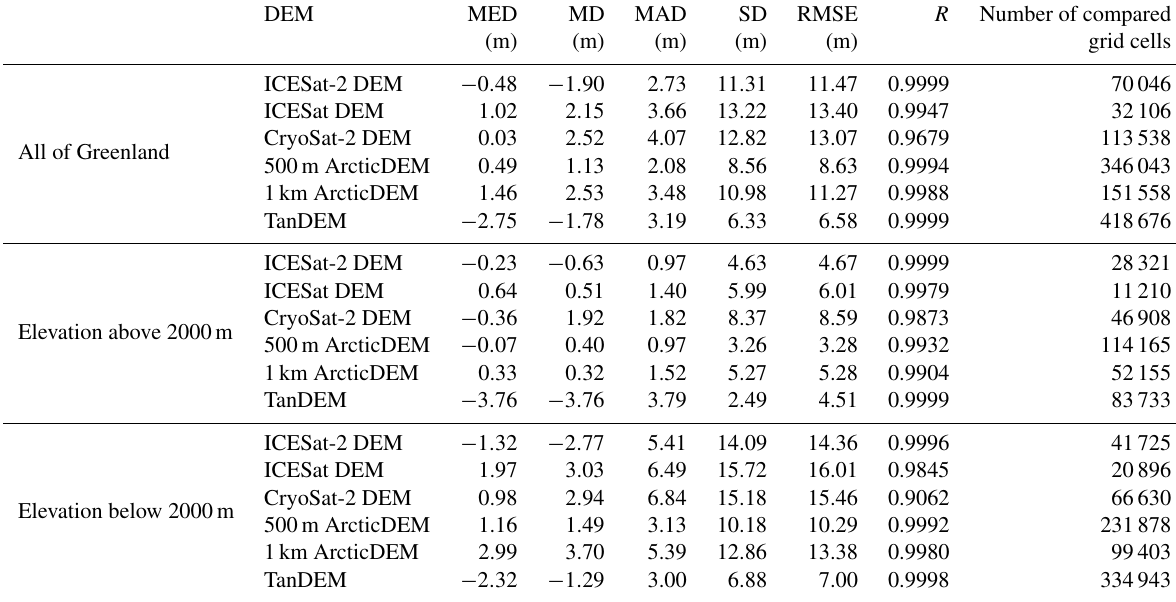
Table 5. Elevation differences of the ICESat-2 DEM and other published DEMs with respect to IceBridge data. All of Greenland and the regions with elevations above 2000m and below 2000m were compared.